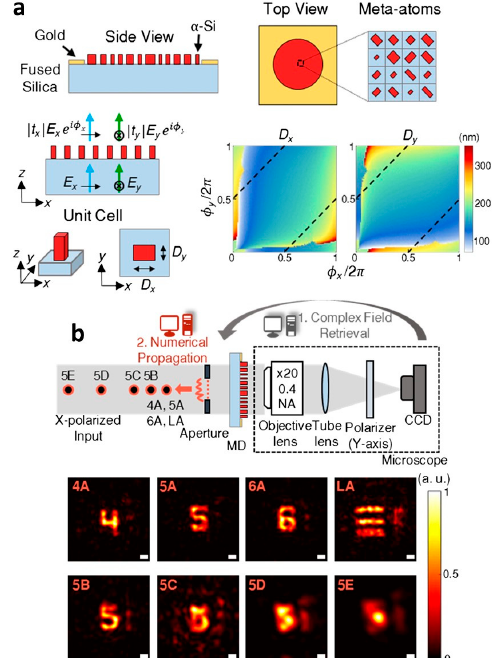
Figure 4. Reference-free holographic imaging using SSM. ( a ) The design of a metasurface diffuser for SSM. A x and A y are amplitude changes for x- and y- polarized light, respectively. φ x and φ y are induced phase delays for x - and y - polarized light, respectively. D x and D y represent the dimensions of the cuboid. The black dashed lines indicate the dimensions for each cuboid to act as a half-wave plate. ( b ) The measured holographic image of targets at different axial locations using the metasurface diffuser. The distances between the points and the aperture are as follows: A, 1.5 mm; B, 2 mm; C, 2.5 mm; D, 3.5 mm; and E, 4.5 mm. MD: metasurface diffuser, CCD: charge-coupled device. Scale bars are 25 μ m. Adapted with permission from [69], OSA Publishing.